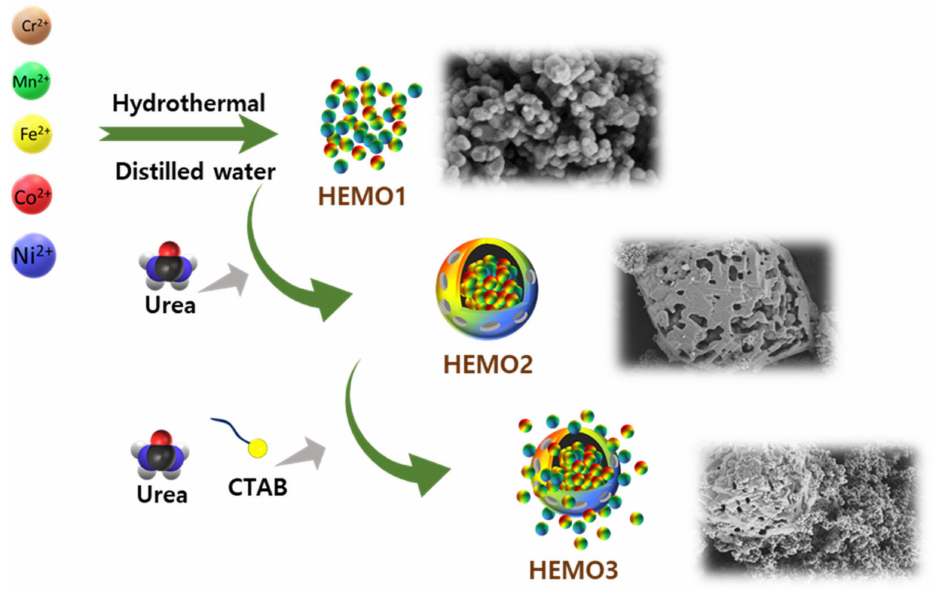
Figure 1. HEMO synthesis process. Schematic presentation of the synthesis procedure for HEMO1, HEMO2, and